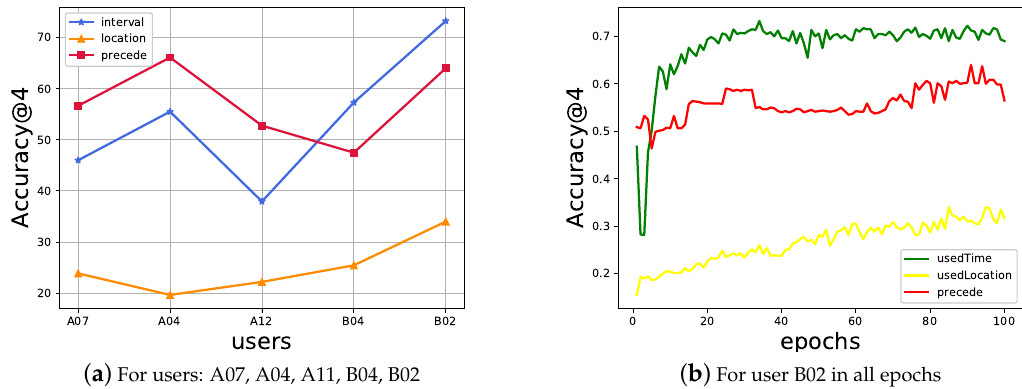
Figure 3. The comparison of prediction Accuracy @4 for the GATNE-I model alone, GE: App and time, App and location, App and the previous App at interval of day